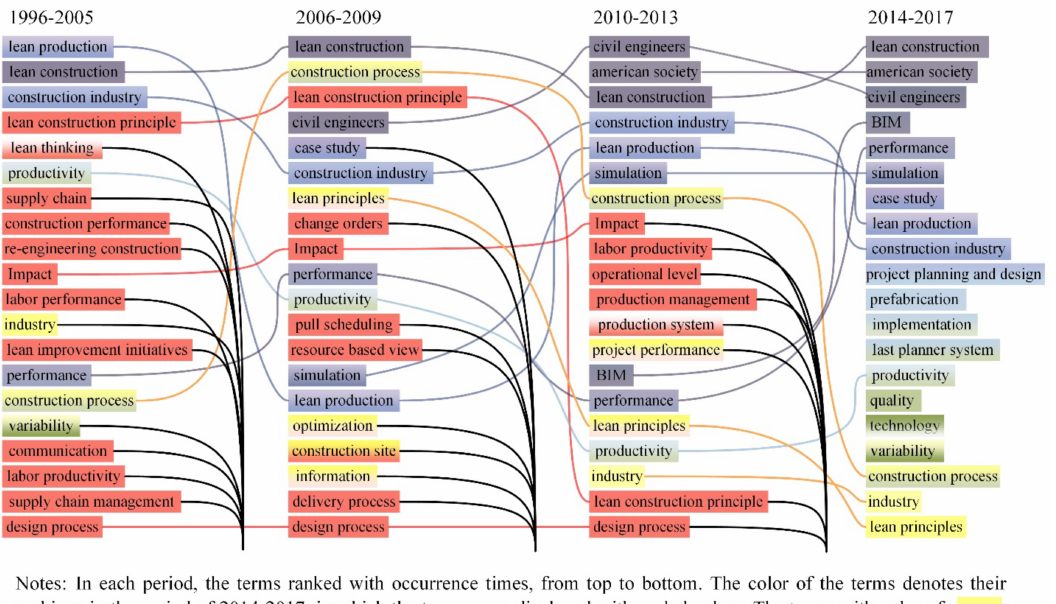
Figure 3. The theme development of Lean Construction in Building